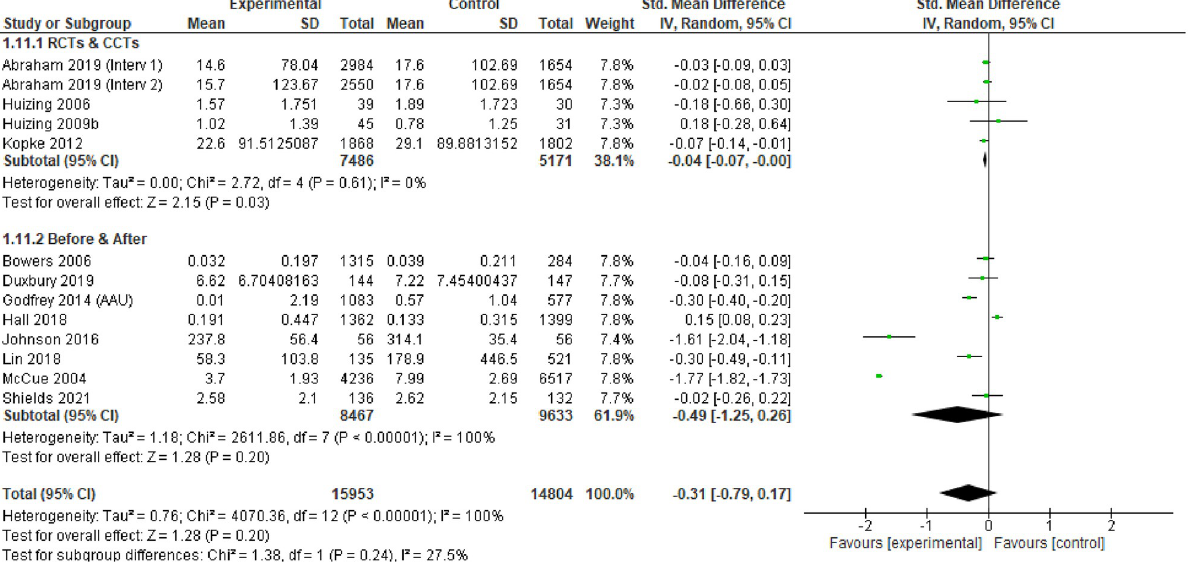
Fig 5. Effectiveness of interventions on the use of restraint by study design, excluding outliers.